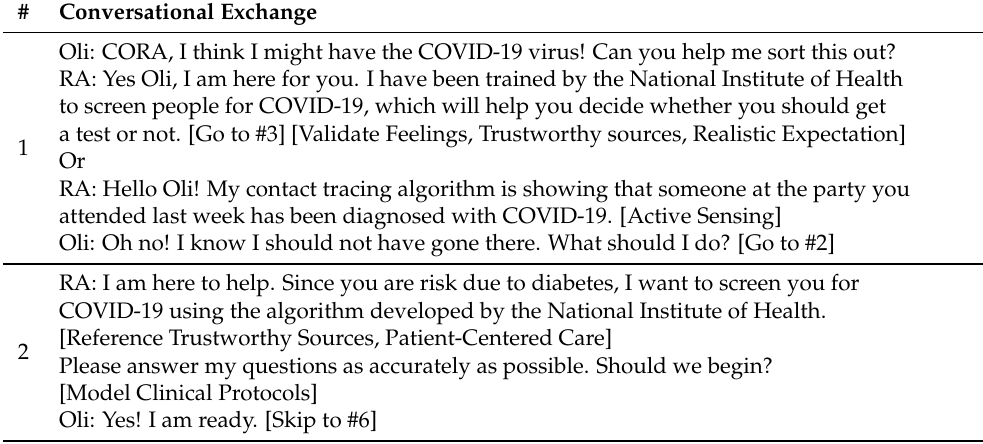
Table A1. Screening for